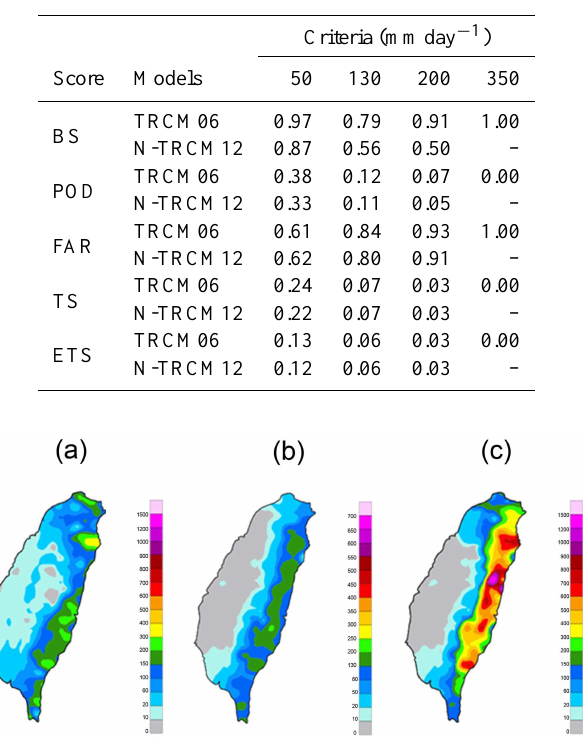
Fig 8. The accumulated rainfall amount associated with Typhoon Mitag (2007) accumulated from 1400 LST 26 November, to 1100 LST 27 November: (a) observed; (b) the rainfall amount forecasted using the TRCM06; and (c) the rainfall amount forecasted using the A-TRCM12 (mm).